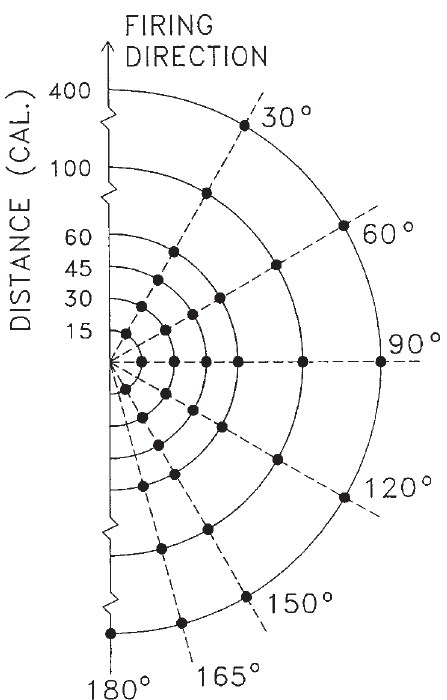
Fig. 1. Gauge positions for the Fansler et al. study